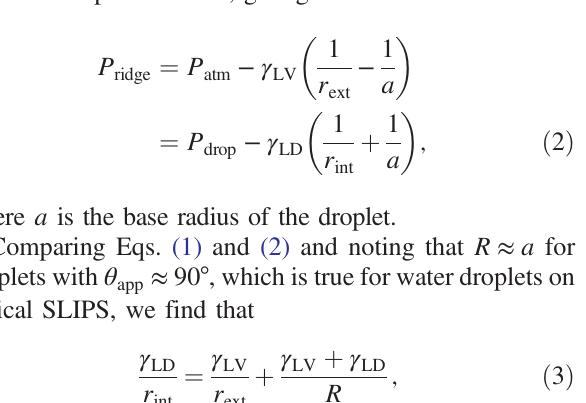
FIG. 1. (a) Schematic showing the geometry of a droplet when a wrapping layer is present ( S the profile of the wetting ridge (scale bar ¼ 25 μ m) around a droplet on fluorescently dyed silicone oil. (c) Measured apparent contact angle vs predicted apparent contact angle based on Eq. (4). The red line indicates a slope of